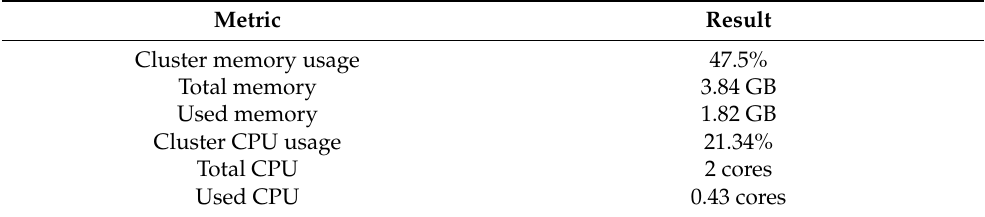
Table 11. Prometheus cluster metrics results.